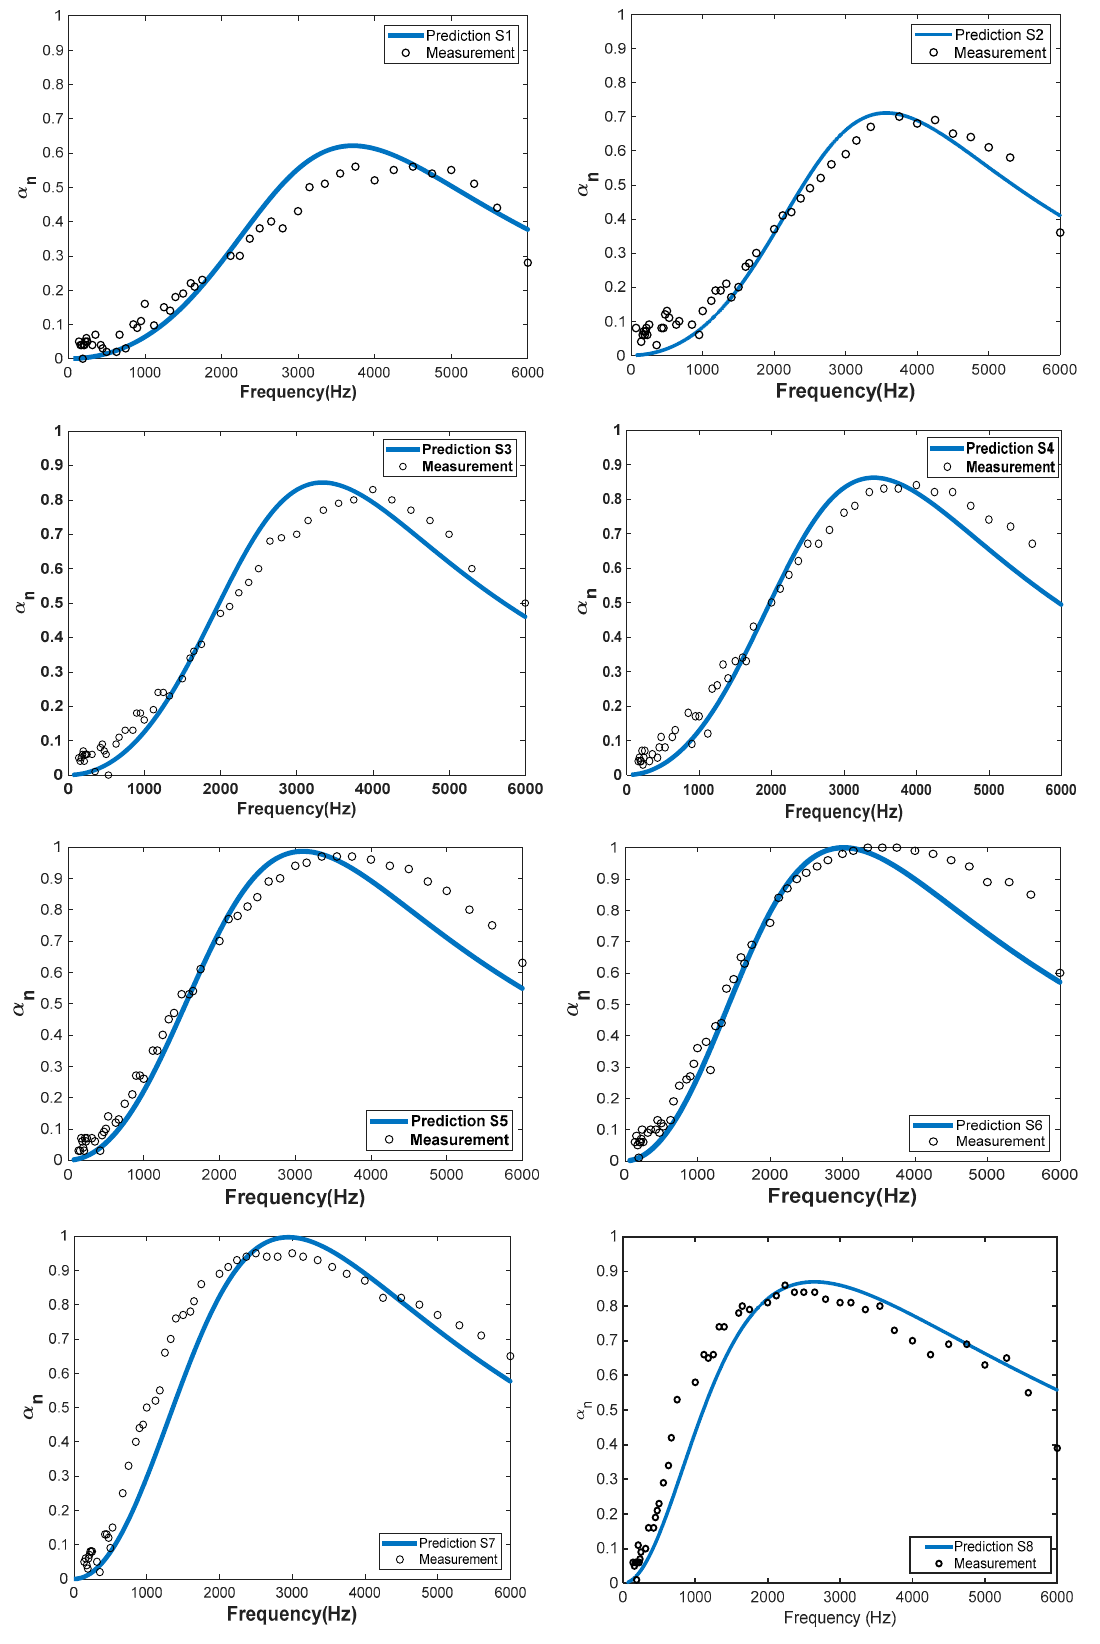
Figure 12. Sound absorption comparison results between Maa’s model and the measurement results for woven fabric S1–S8. for woven fabric